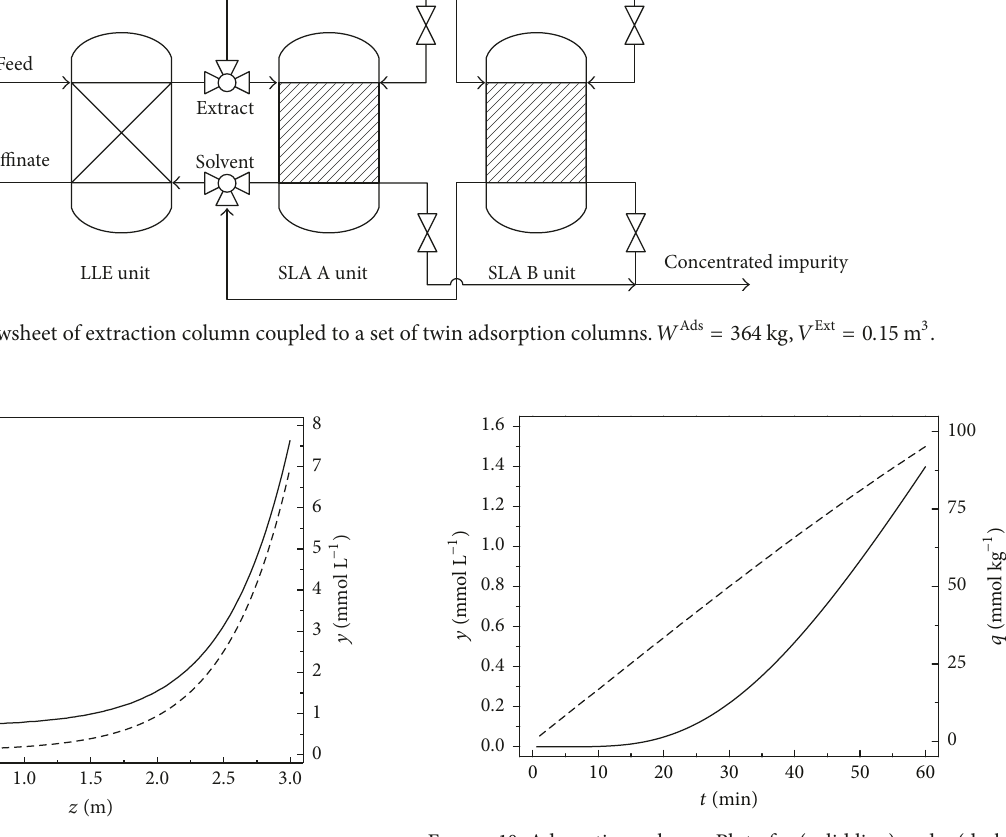
Figure 9: Plot of 𝑥 (dashed line) and 𝑦 (solid line) as a function of the position in the countercurrent extraction column. 𝑄 Feed = 4 Lmin −1 , 𝑄 Solv = 80 Lmin −1 , 𝑥 Feed = 0.140mol L −1 , 𝑦 Solv = 0.7 mmolL −1 .